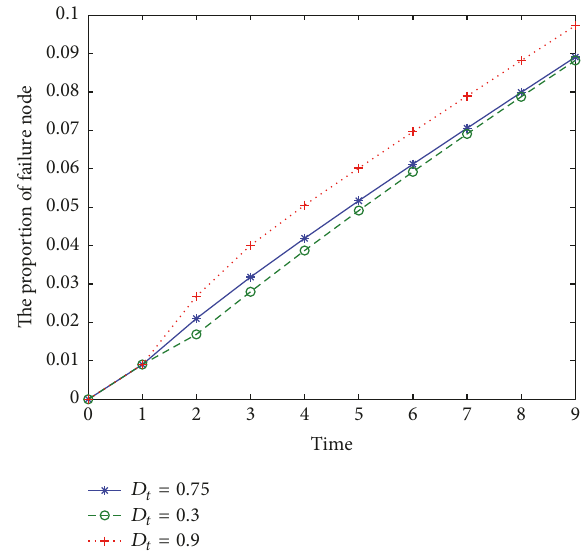
Figure 10: The proportion of failed